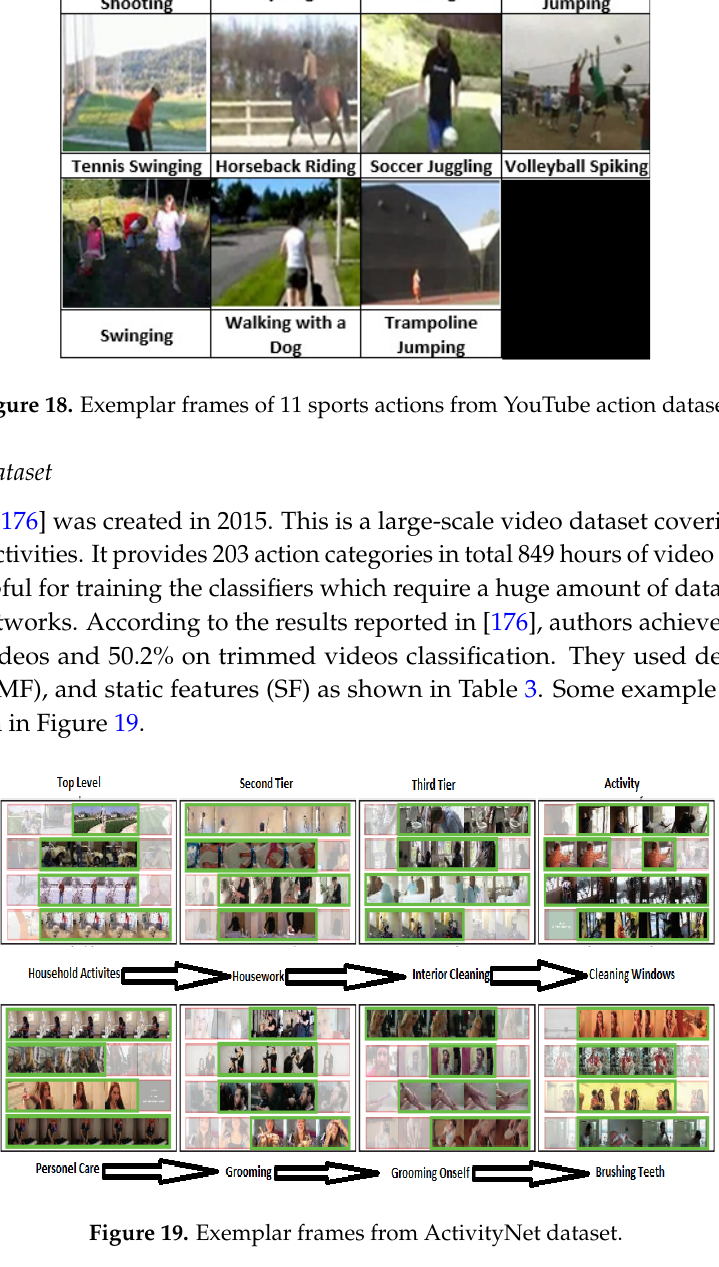
Figure 17. Exemplar frames from sports action dataset.